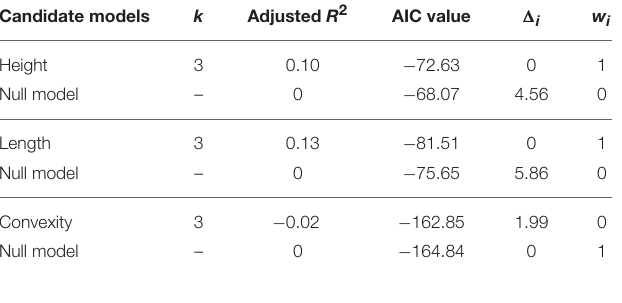
TABLE 3 | Effect of beetle morphology and diet specialization on color pattern